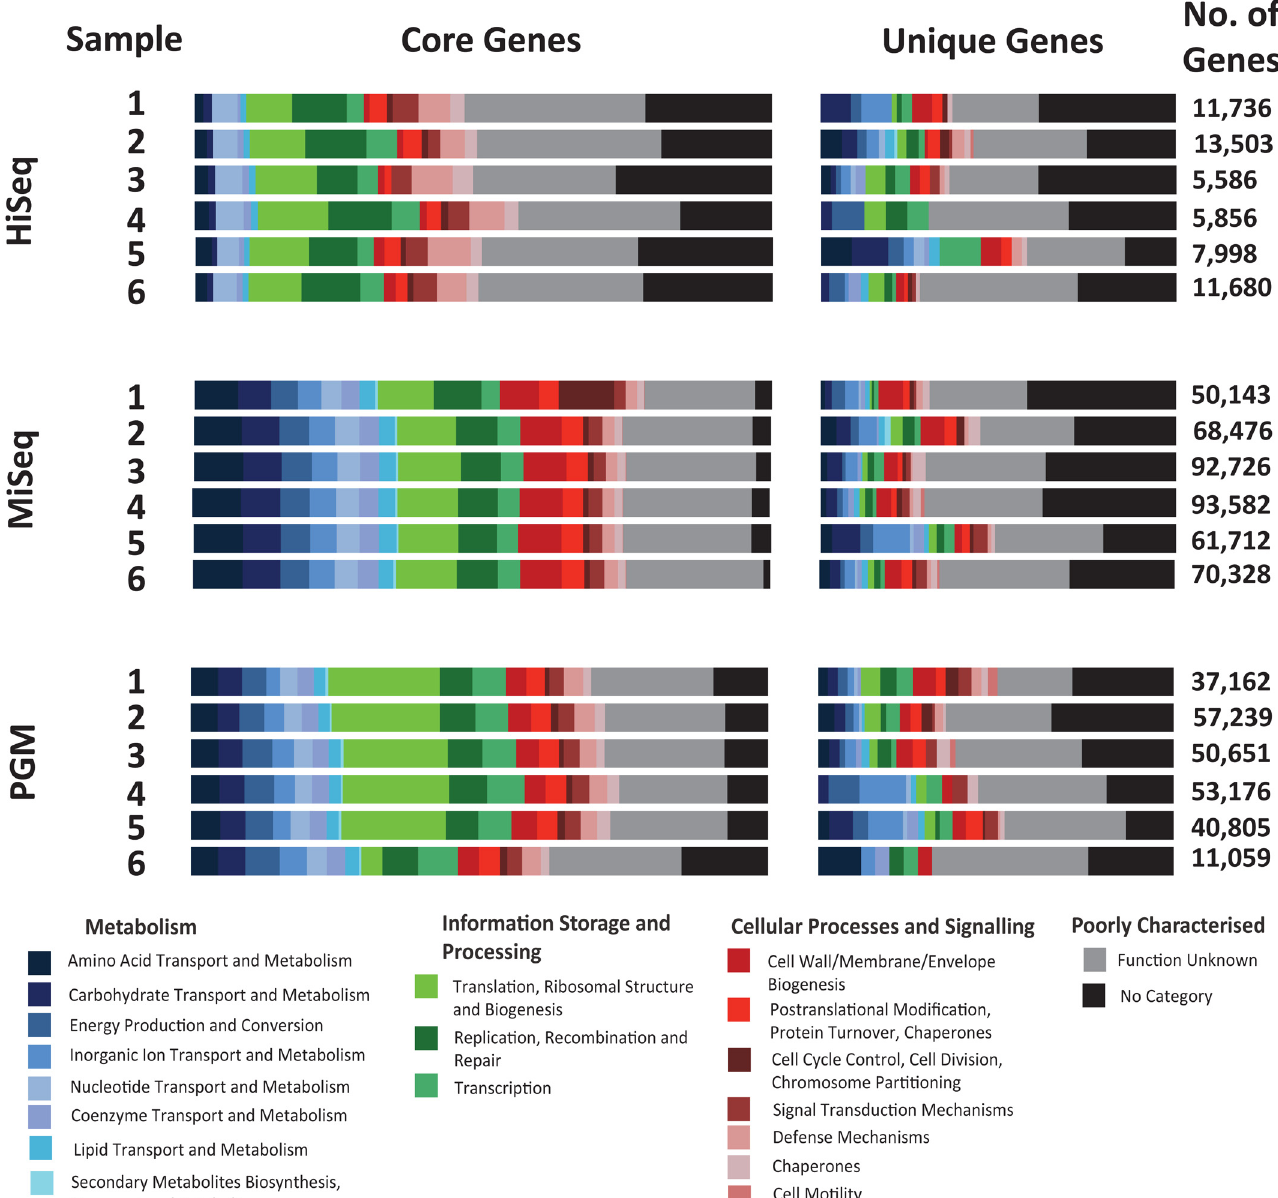
Fig 6. Core and unique genes acquired by Metaphor with 600,000 sequencing randomly selected datasets for each of the samples. The numbers represent the total number of predicted complete or incomplete genes for each